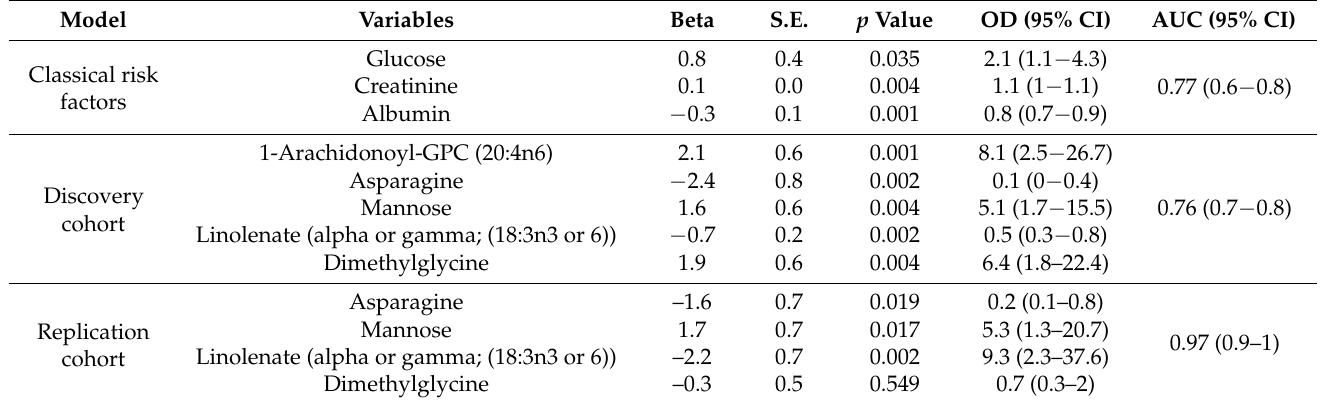
Figure 2. Receiver operating characteristic (ROC) curve indicates best predictors of BMI groups using ( A ) three classical traits (glucose, creatinine and albumin), ( B ) five CHD metabolites in the discovery cohort (1-arachidoniolyl GPC, asparagine, mannose, linolenate and dimethylglycine) and ( C ) four CHD metabolites in replication cohort (asparagine, mannose, linolenate and dimethylglycine). Area under the curve (AUC) for each model indicates the prognostic value of the classifier. Table 2. Coronary heart disease (CHD) classical traits and metabolites differentiating apparently healthy overweight from lean females. Logistic regression was used to assess the relationship between BMI groups and the CHD metabolites. OR—odds ratio, CI—confidence intervals. p -value significance levels of 0.003 and 0.01 were used in the discovery and replication cohorts, respectively, to infer